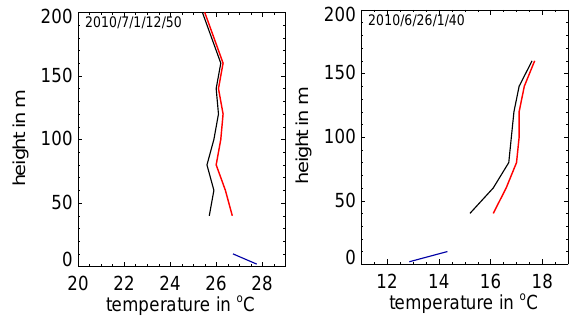
Fig. 5. Temperature profiles at Munich airport without (black) and Figure5:Temperaturepro(cid:28)lesatMuni hairportwithout(bla k)andwith orre tions(red).